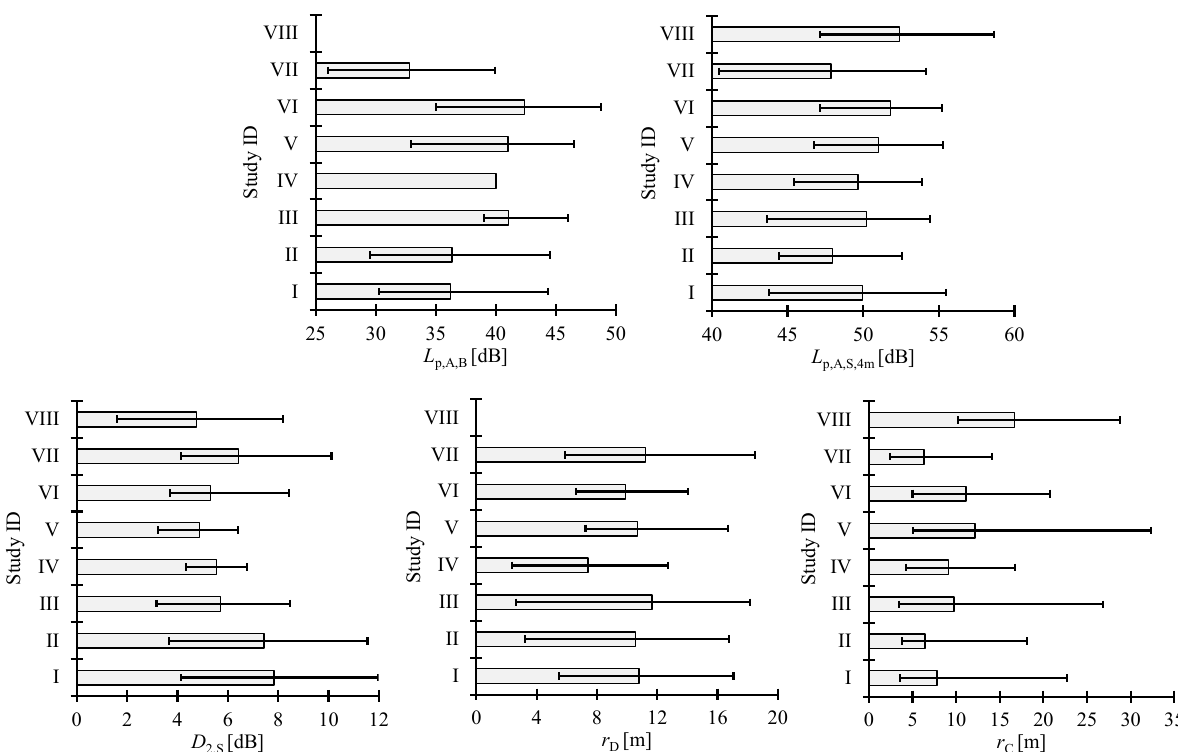
Figure 6. Distribution of measurement results according to ISO 3382-3 standard in the eight studies of Table 2. Bars are the means and whiskers are the 95% confidence intervals.